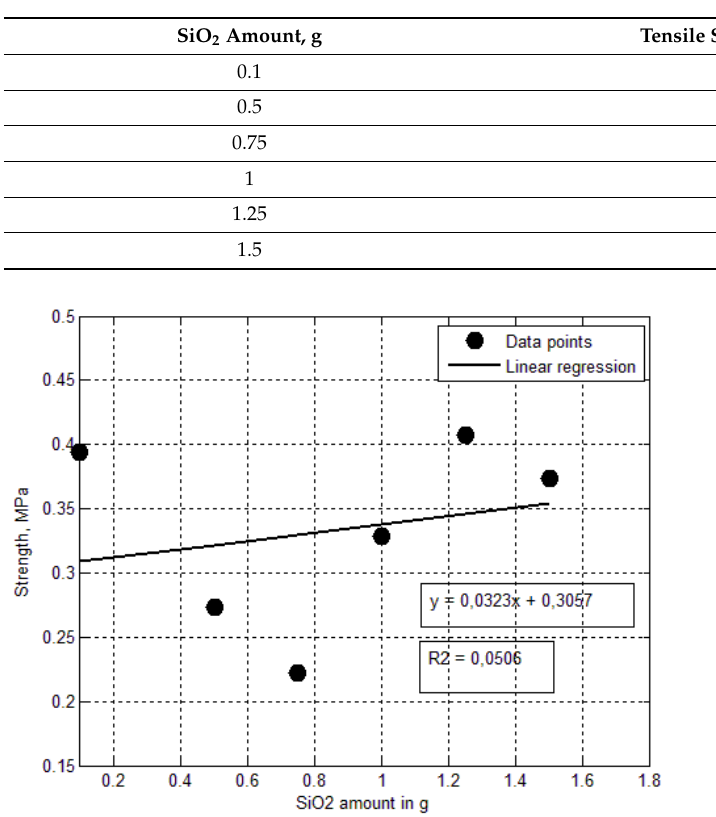
Table 2. Data used in the regression analysis of tensile strength of BIN composite samples.